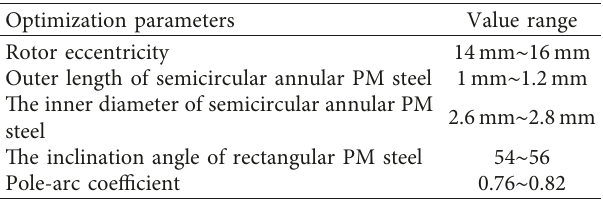
Table 3: Optimization parameters and their value